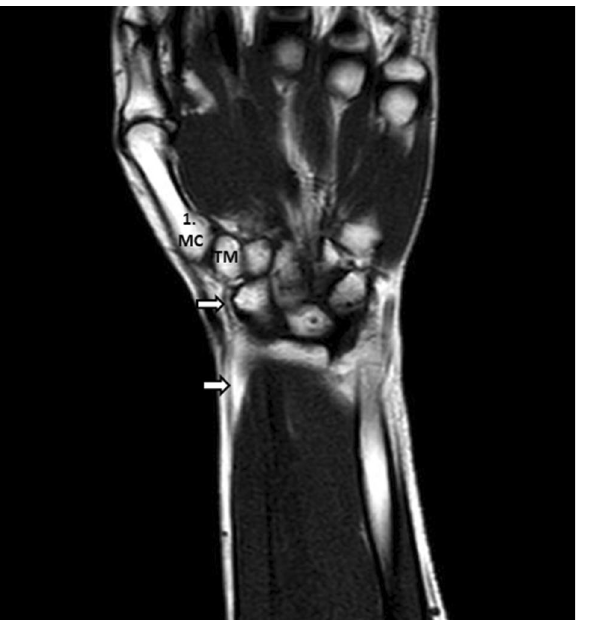
Figure 4. Coronal T1W TSE MR image of the wrist; m. flexor carpi radialis tendon (arrow), os metacarpale (MC), os trapezium (TM).